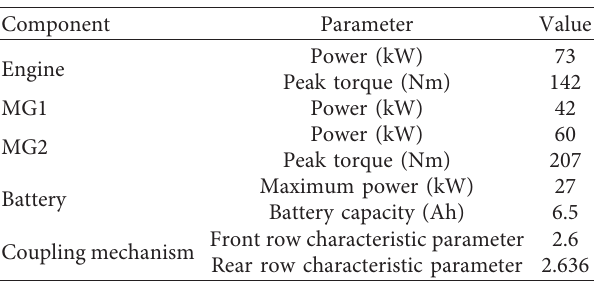
Figure 1: Double-row planetary gear power coupling system. Table 1: The main components and parameters of the hybrid electric